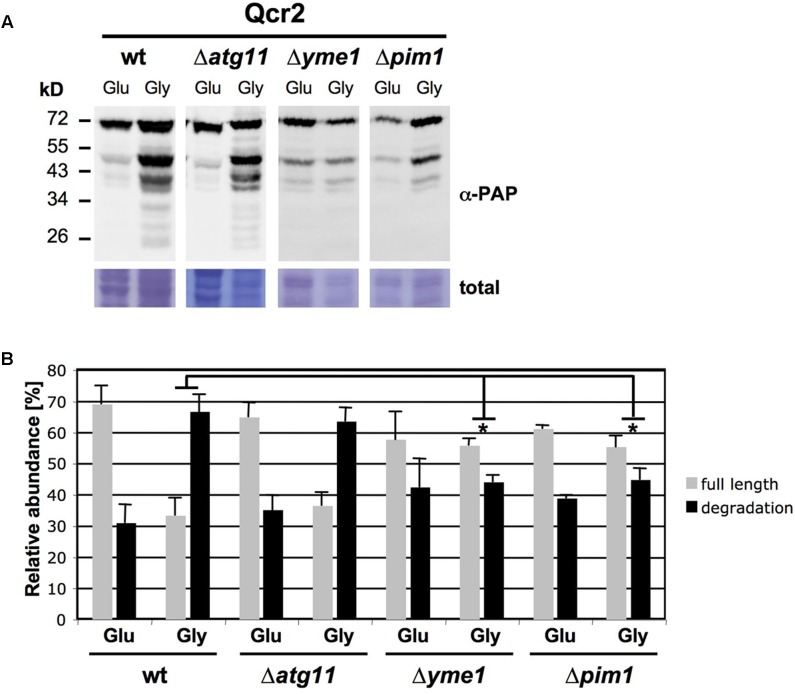
Enhanced degradation of Qcr2 upon respiratory growth depends on the mitochondrial proteases Yme1 and Pim1. (A) Qcr2 protein degradation in the indicated mutant strains was assessed by western blot as described in Figure 1. A representative blot is shown. (B) Quantification of the ratio of full length and degradation products of the Qcr2 protein. Mean values with the standard deviation are shown based on three independent experiments. Significantly different degradation rates between different strains are marked: ∗p < 0.05 (Student’s t-test). All other comparisons were not statistically different.